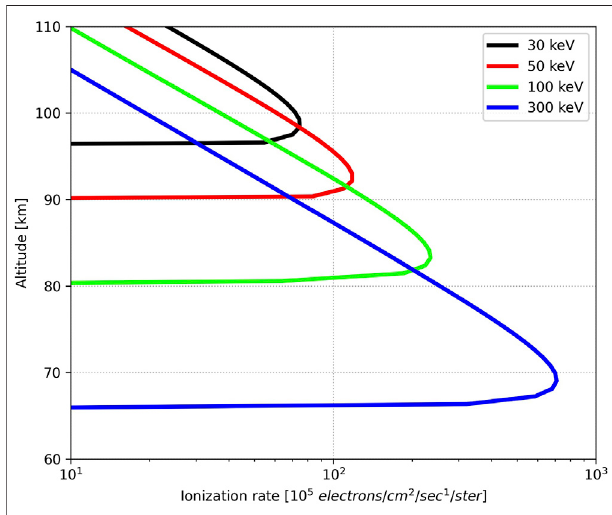
FIGURE 1 | Ionization rates versus altitude for monoenergetic electron fl ux based on the models described in Artamonov et al., 2017 and Mironova et al.,